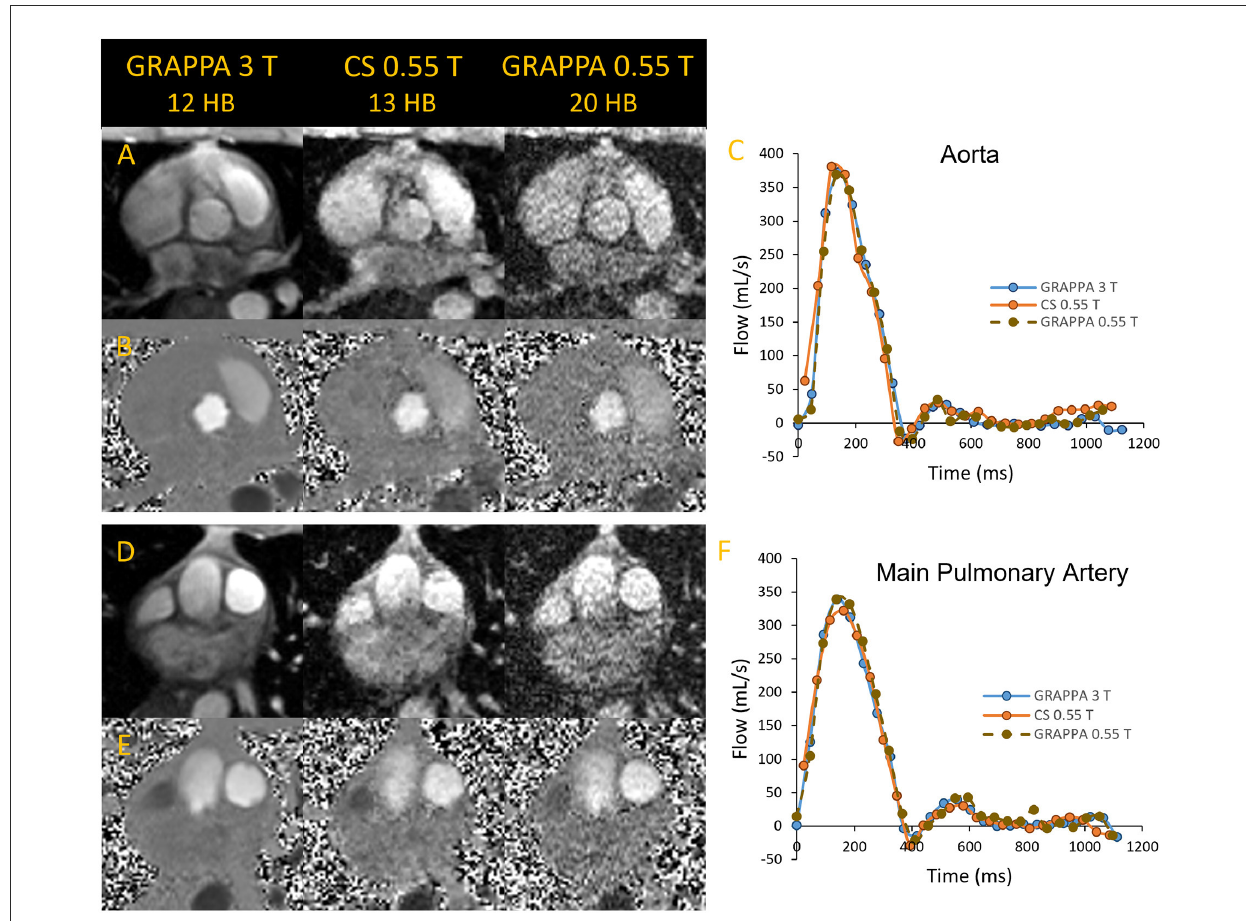
FIGURE4 Magnitude and phase images of the aorta (A, B) and main pulmonary artey (D, E) acquired in a volunteer using segmented GRAPPA at 3T as reference and compared to compressed sensing and GRAPPA images at 0.55T. The flow curves corresponding to the images are shown in (C, F)